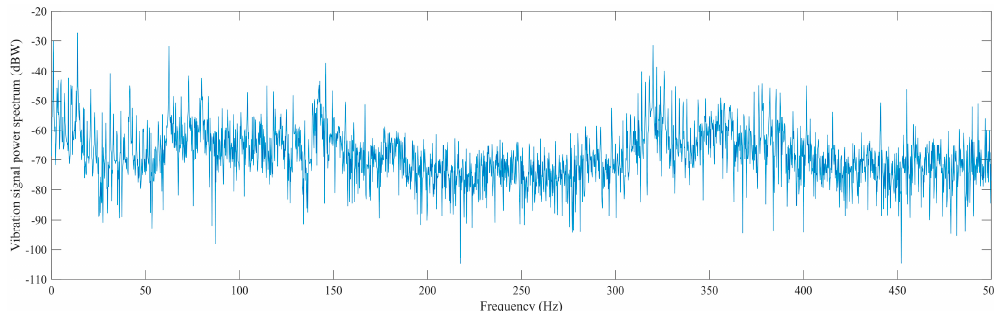
Figure 7. The power spectrum of the vibration signal.